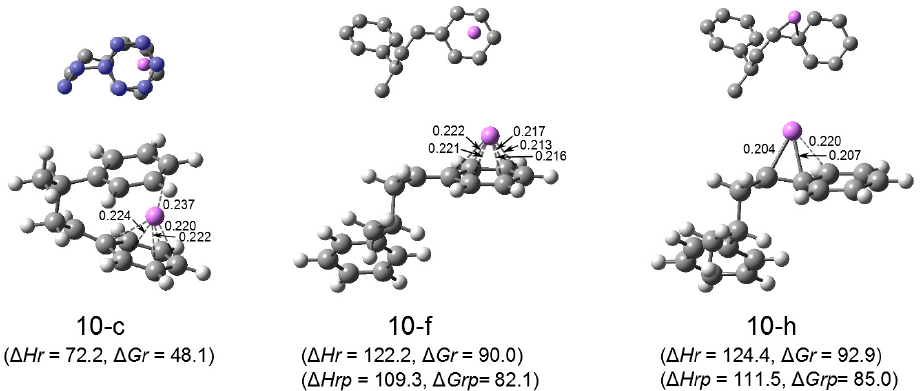
Figure 10. Optimized geometries and relative energies of representative HSt 2 Li structures with and without the penultimate unit coordination in the gas phase. The small drawing on the upper part of each structure is the simplified overhead view of the lower drawing; for (10-c), the carbon atoms of the penultimate styrene unit are colored in blue. C–Li distances less than 0.225 nm, and the distance between Li and the nearest penultimate-unit carbon for (10-c) are shown in the lower drawings. ∆ Hr and ∆ Gr , the relative enthalpy and relative free energy, are expressed in kJ·mol –1 . ∆ Hrp and ∆ Grp in the lower parentheses for (10-f) and (10-h) are the enthalpy and free energy with respect to 1/2[(HSt 2 Li) 2 (9-f)], in kJ·mol –1 .